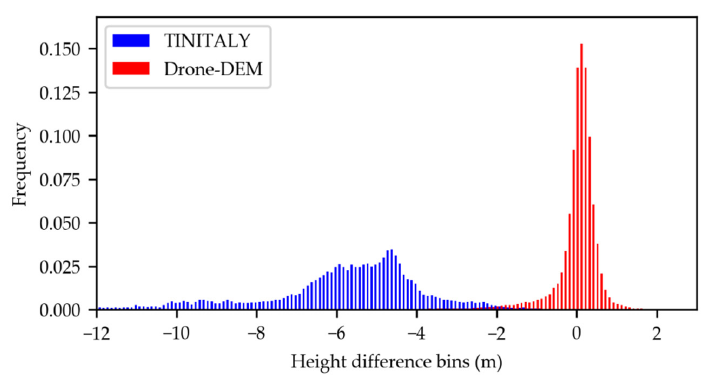
Figure 5. Distributions of the height differences of the TINITALY and Drone-DEM with respect to the LiDAR.